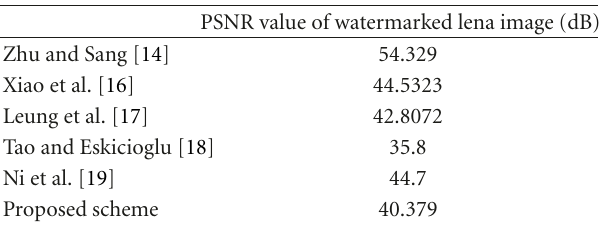
Figure 2: The extracting procedure. Table 1: The values of